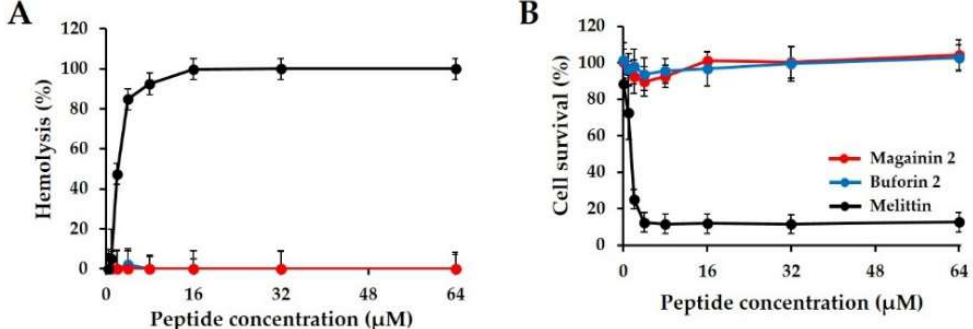
Figure 3. Cytotoxicity and hemolytic activity of magainin 2. ( A ) Hemolytic activity of peptides against mouse red blood cells (RBCs). ( B ) Cytotoxicity of peptides against HaCaT cells.